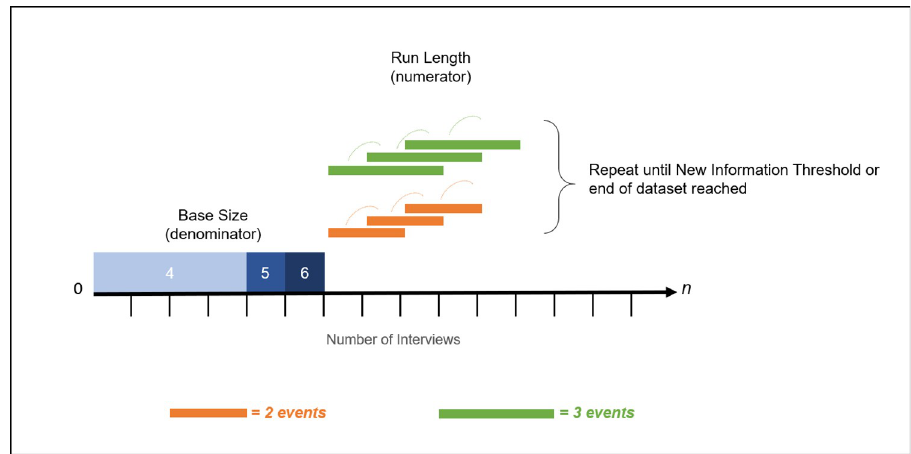
Fig 1. Summary of process, base size and run length